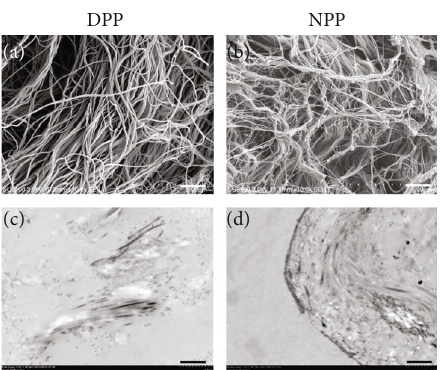
Figure 3: Ultrastructural analysis of (a, c) DPP and (b, d) NPP. (a, b) Scanning electron microscopy images and (c, d) transmission electron microscopy images showed the intact collagen fi brils after decellularization (scale bar ð a, b Þ = 5 μ m , scale bar ð c, d Þ = 1 : 0 μ m